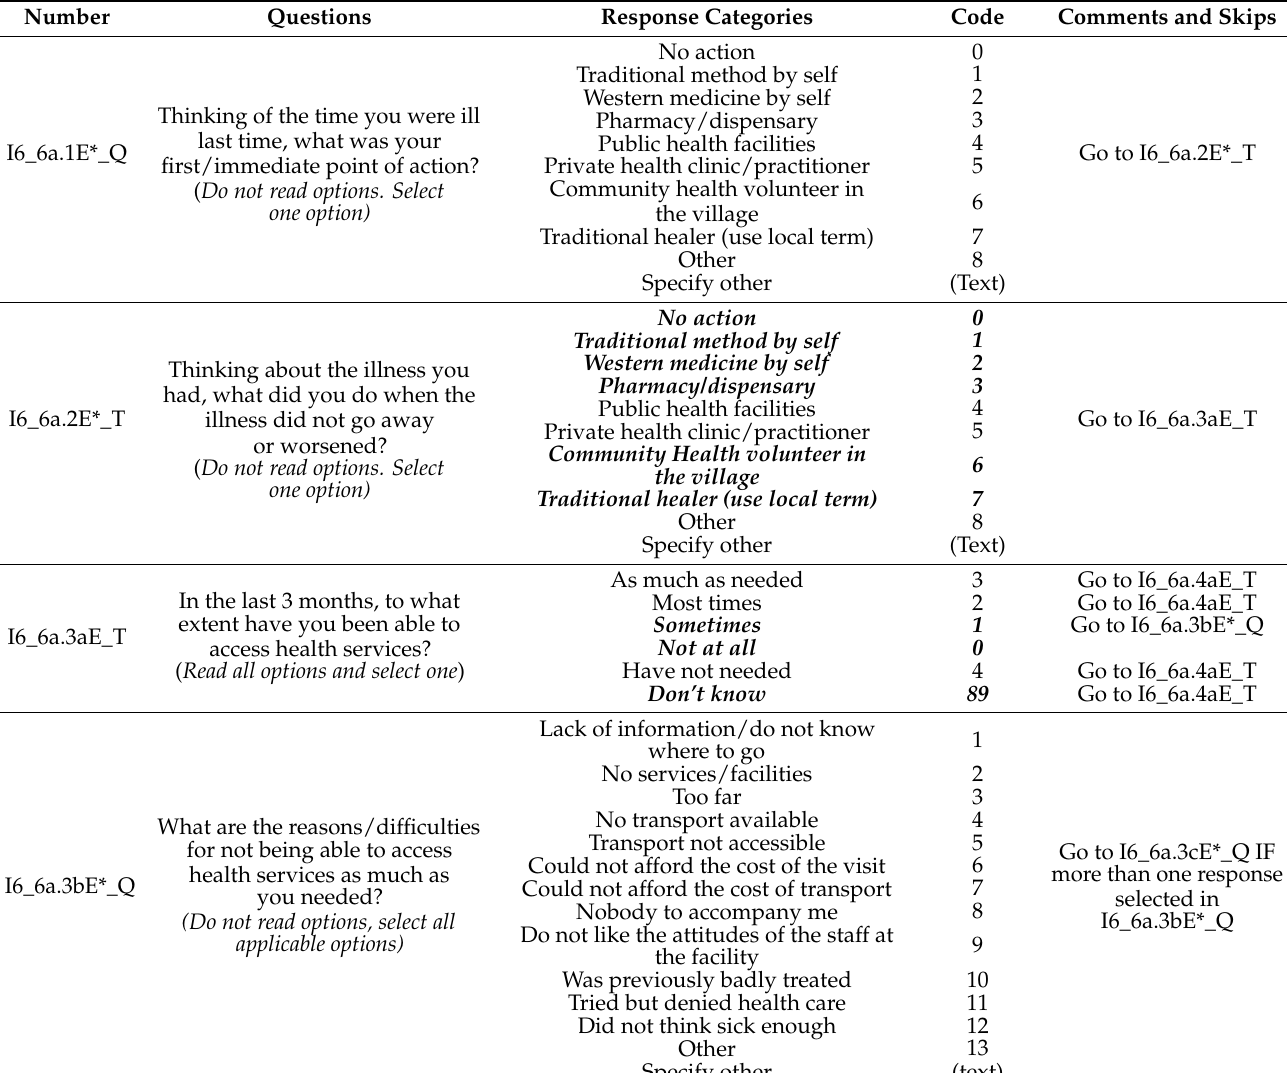
Table 2. Module 6, Access to and utilization of health